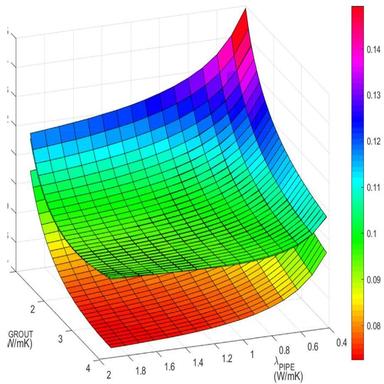
Graphic showing the simultaneous effect of varying the lPIPE and lGROUT in the Rb of a designed system for a house in a mild region with high (bottom), medium (middle) and low (upper) thermal conductivity of the ground.